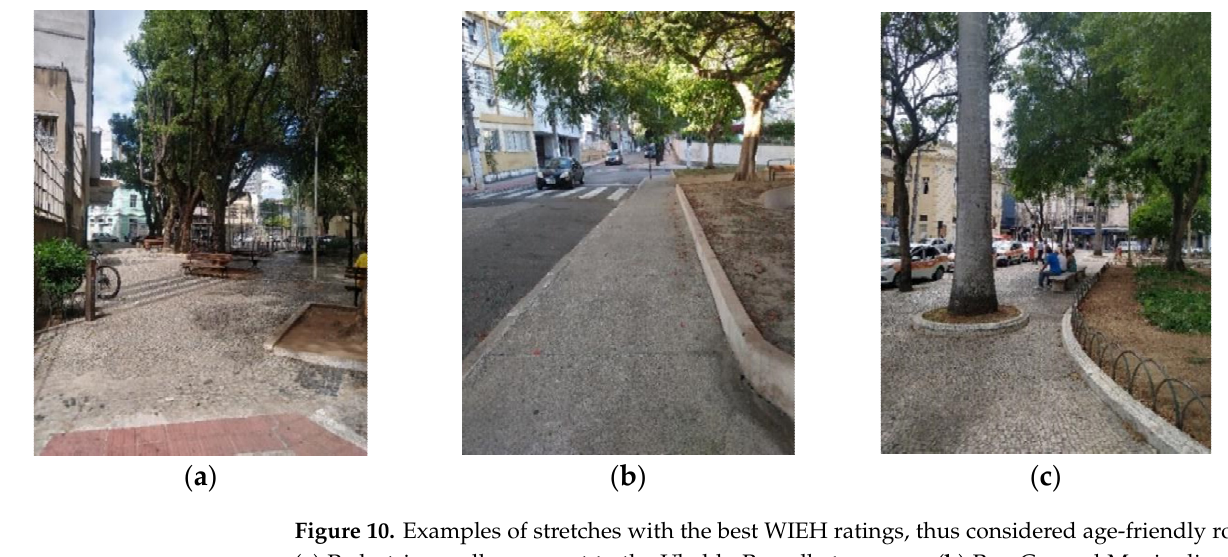
Figure 10. Examples of stretches with the best WIEH ratings, thus considered age-friendly routes. ( a ) Pedestrian walkway, next to the Ubaldo Ramalhete square; ( b ) Rua Coronel Monjardim, next to Praça Irm ã Josefa Hosana and near the Senior Citizen Center; ( c ) sidewalk at Costa Pereira Square, a major city landmark, surrounded by the Carlos Gomes Theater and Gl ó ria Theater—it provides access to Cidade Alta and to tourist attractions such as the S ã o Diogo Staircase and the Metropolitan Cathedral.